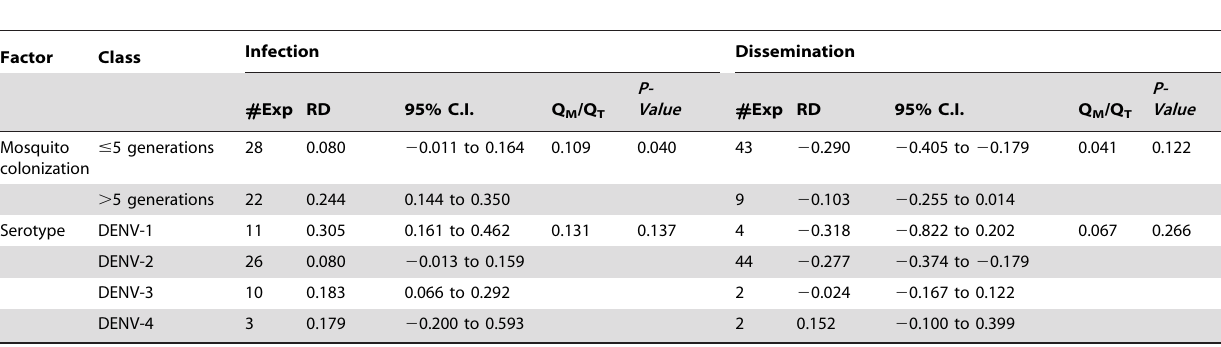
Table 1. Influence of categorical factors on the relative oral susceptibility to DENV of Ae. albopictus compared to Ae. aegypti measured by the rate of midgut infection and the rate of virus dissemination from the